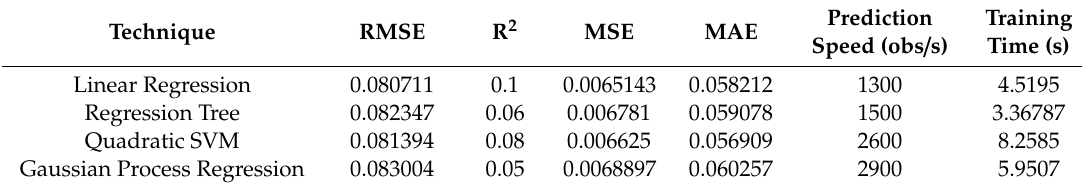
Table 2. Comparison of thermal conductivity validation results with other techniques.